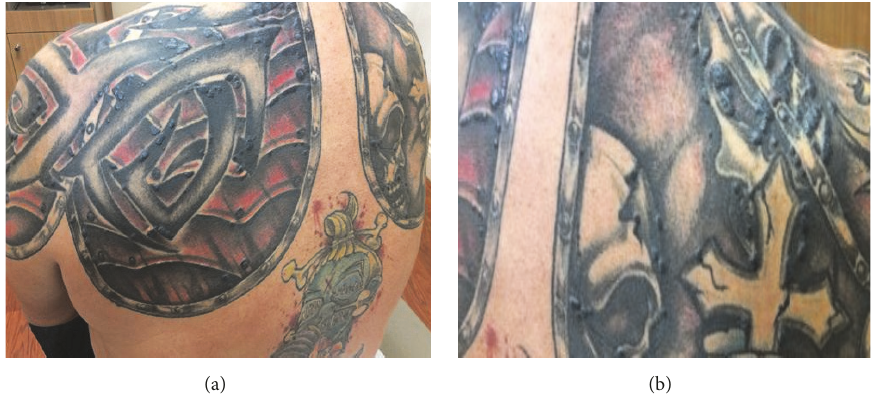
Figure 2: (a), (b). Papulonodular lesions within the black tattoos in patient 2.